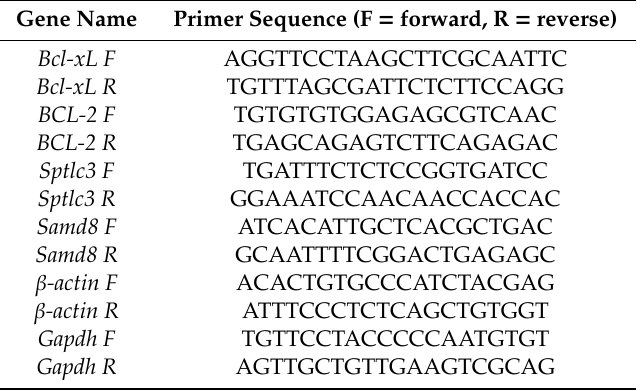
Table 1. Mouse cDNA primer